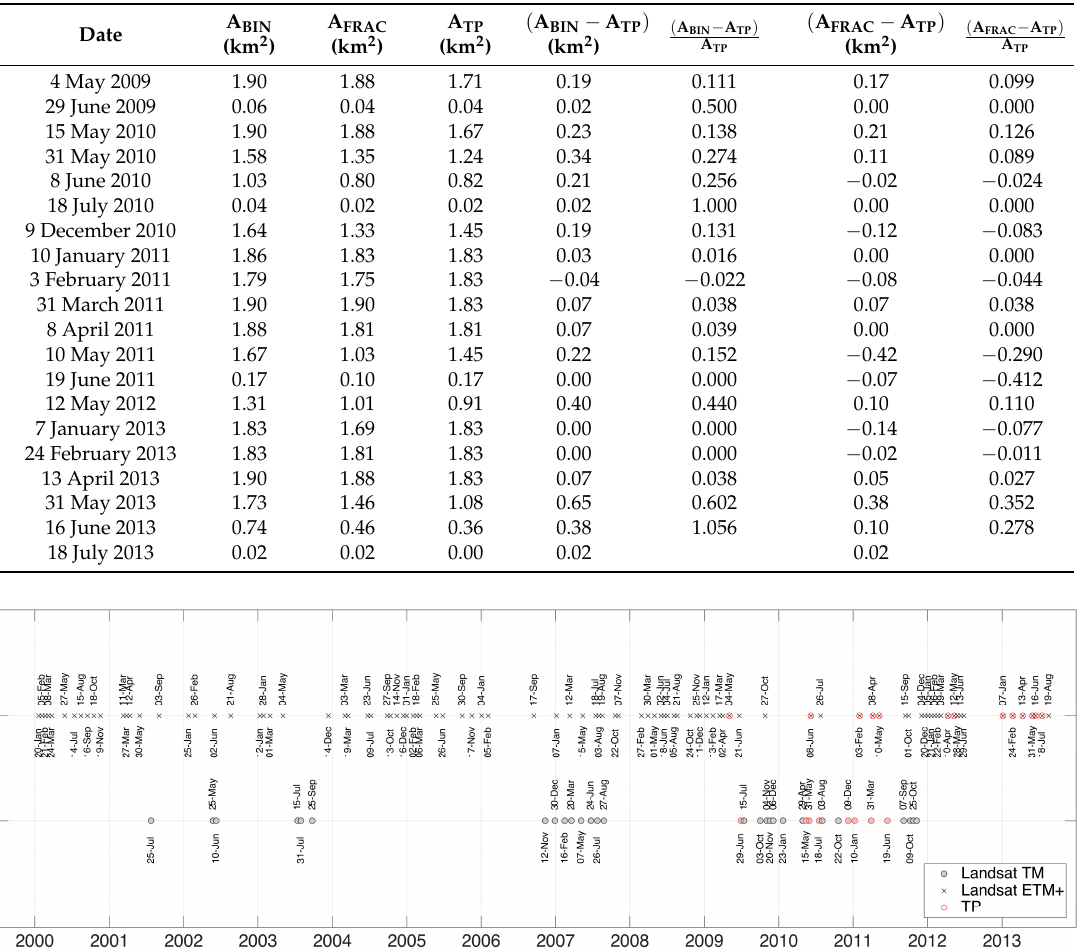
Table 2. Snow cover area calculated from Landsat-binary (A BIN ), Landsat-fractional (A FRAC ) and TP (A TP ), and absolute and relative error associated to each Landsat map and date at the 2-km 2 validation control area. A BIN (km 2 )